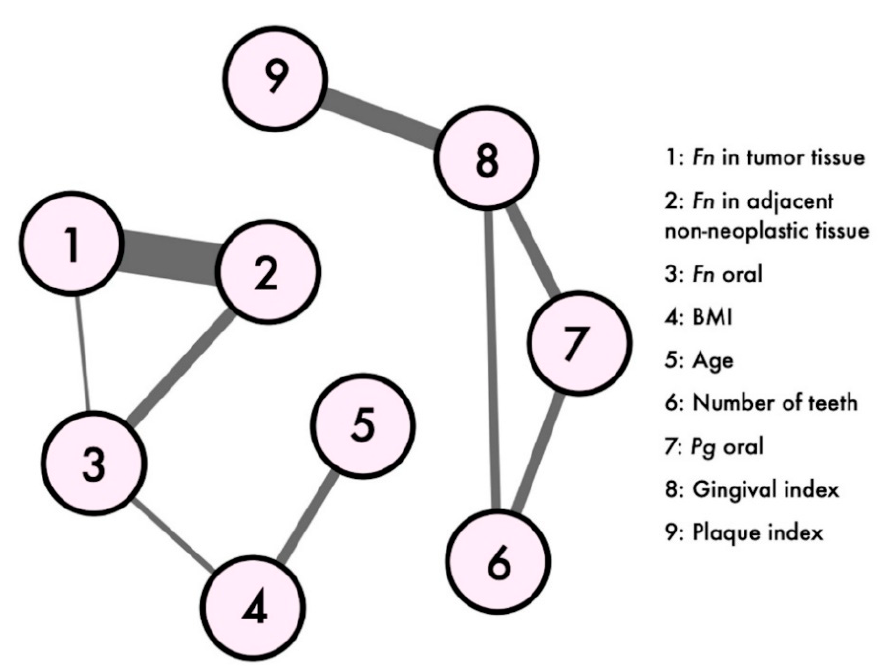
Figure 2. Network plot. Network plot of the cancer patients variables, including the Fn and Porphyromonas gingivalis ( Pg ) quantities, oral health parameters, age and body mass index (BMI); labels are shown for weights over 0.24 Spearman correlation coefficients (rho). The thicker the line, the highest the weight of the correlation between the nodes. Nodes were positioned using the Fruchterman-Reingold algorithm. Density: 0.25, number of observations: 34 and missed values were excluded pairwise.